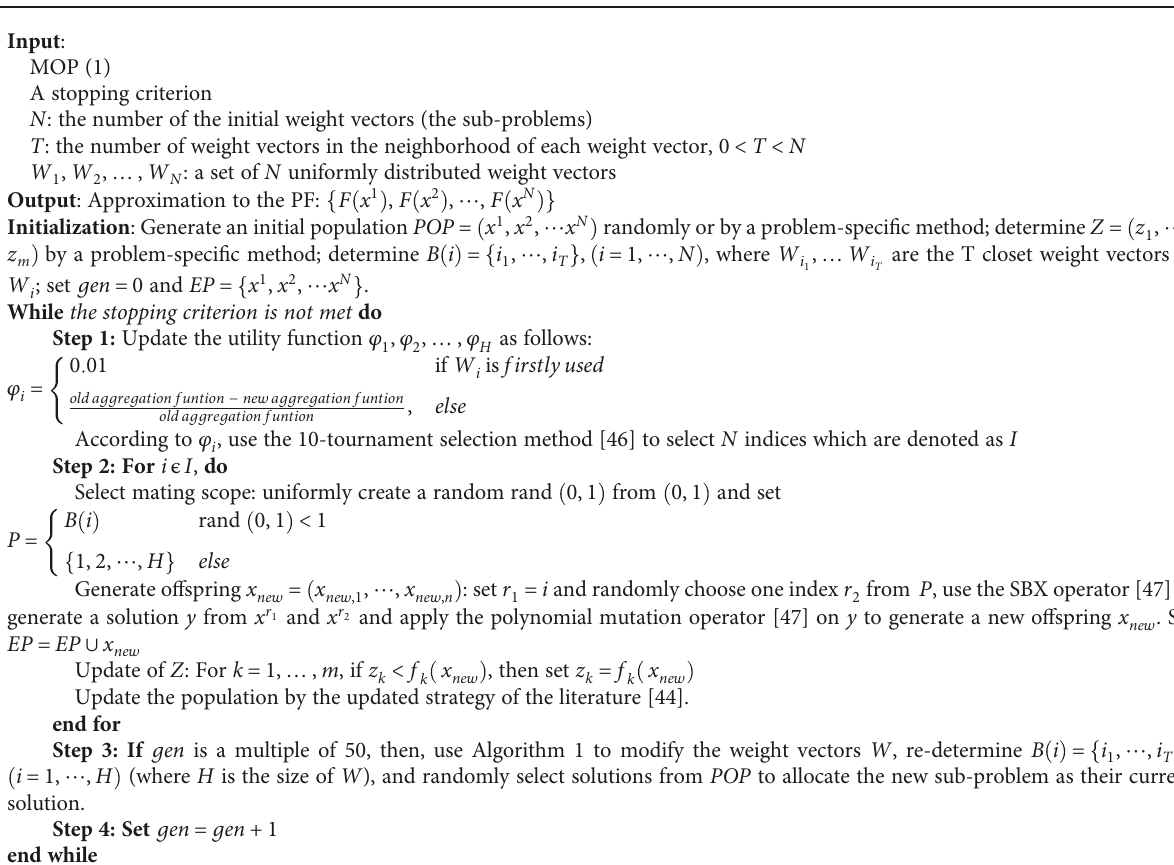
Pseudocode 1: The pseudocode of the algorithm